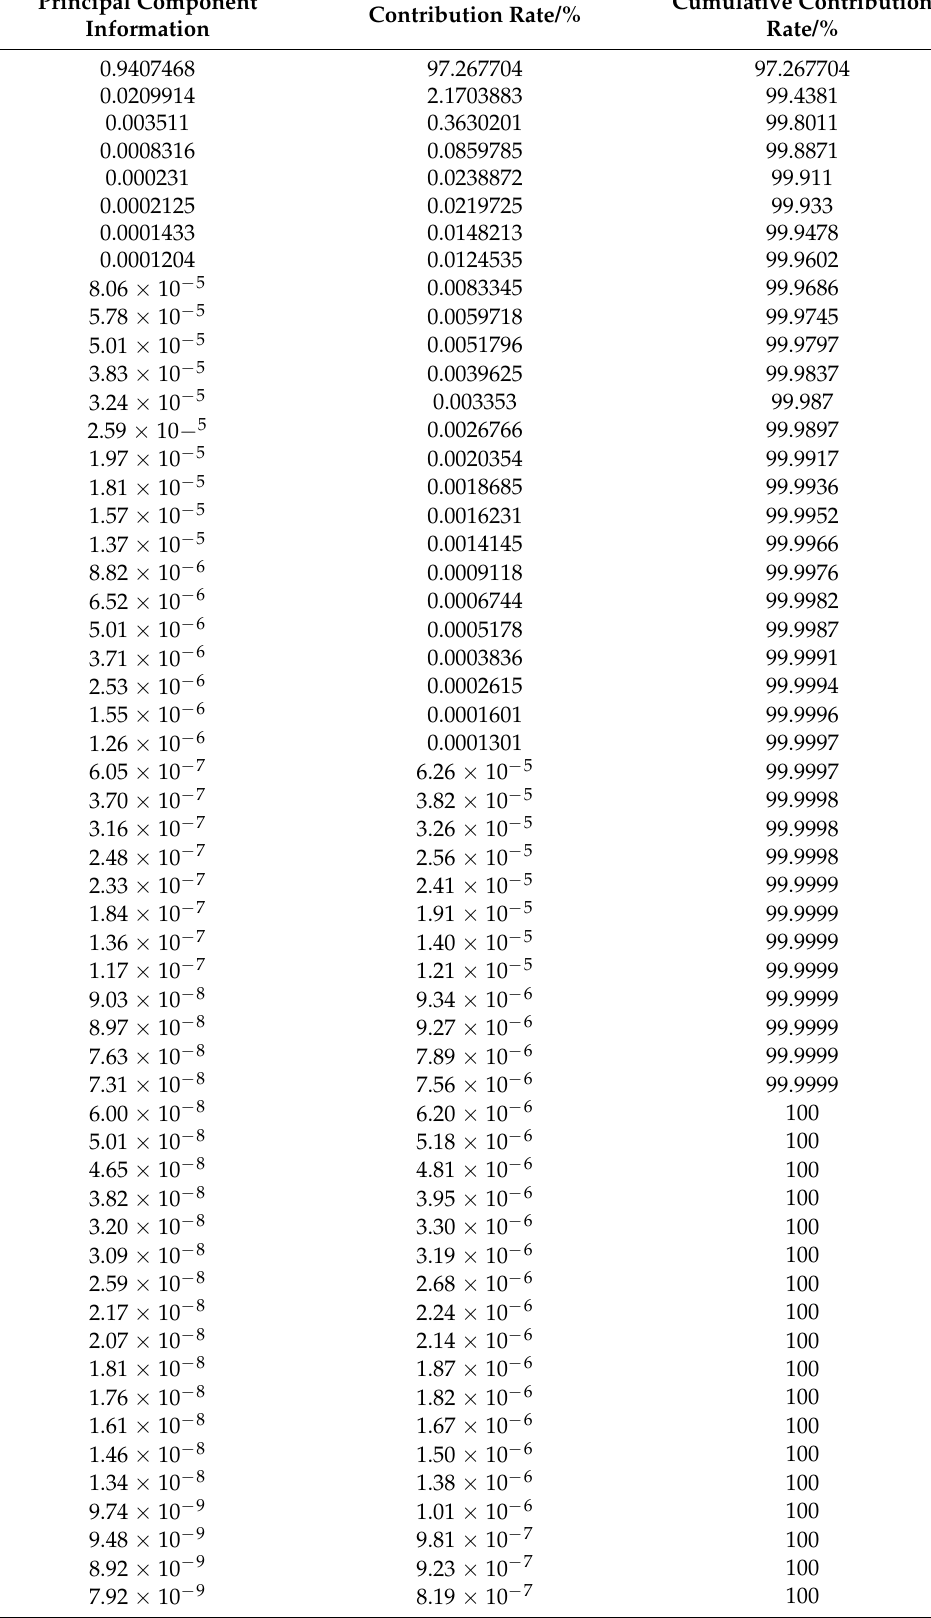
Table 8. The principal component analysis